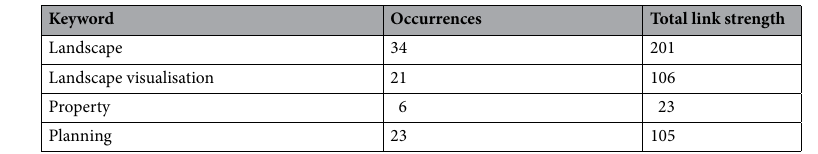
Table 3. The result of keyword search for “Visualisation 3D” in the context of spatial planning and development. Source own